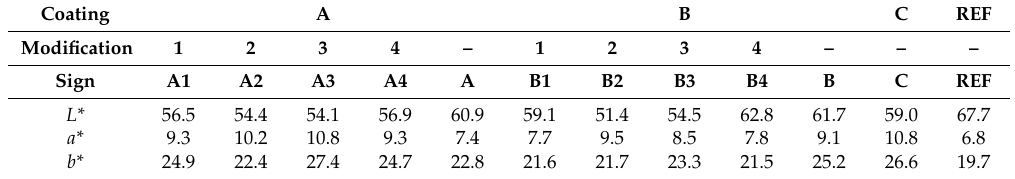
Table 2. Initial colour parameters L* , a* , b* (CIELab 1986 [58]) of the tested samples.